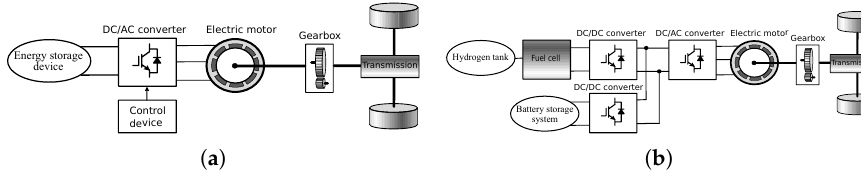
Figure 7. Electric motor vehicles. ( a ) Battery electric vehicles. ( b ) Fuel cell electric